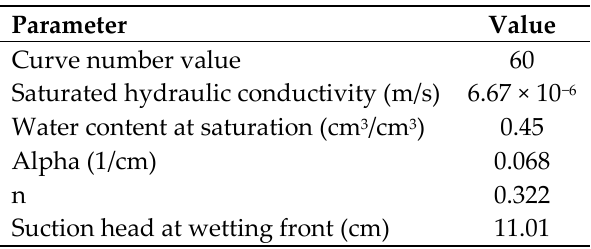
Table 1. Soil parameters used for model